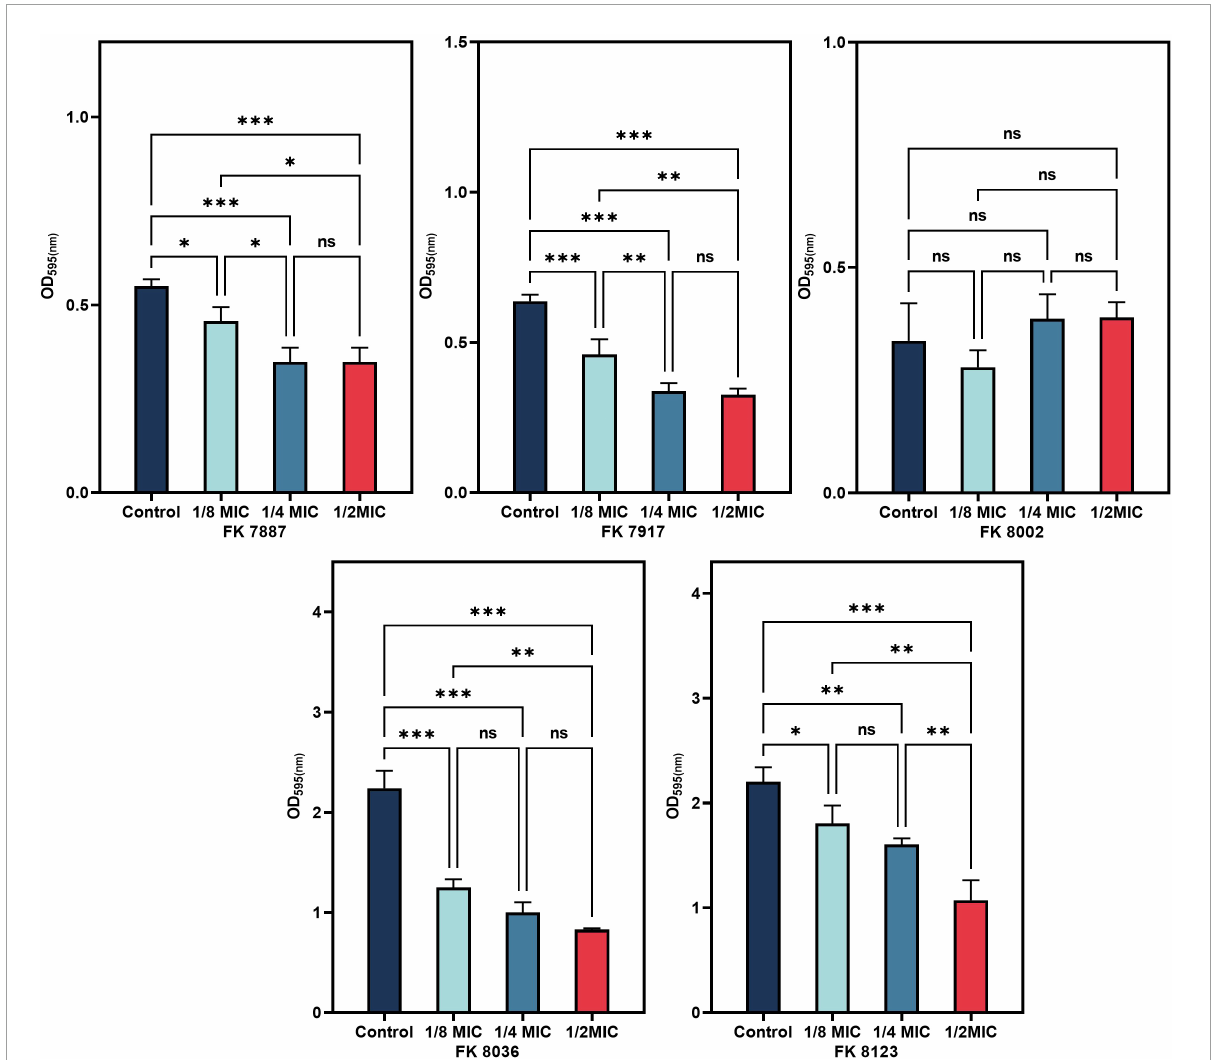
FIGURE7 The inhibitory effect of biofilm formation of five carbapenem-resistant Klebsiella pneumoniae (CRKP) treated with chlorogenic acid (CA) at 1/2, 1/4, and 1/8 minimum inhibitory concentration (MIC). “ ∗ ” Means P < 0.05, “ ∗∗ ” means P < 0.01, “ ∗∗∗ ” means P < 0.001, and “ns” means P > 0.05.